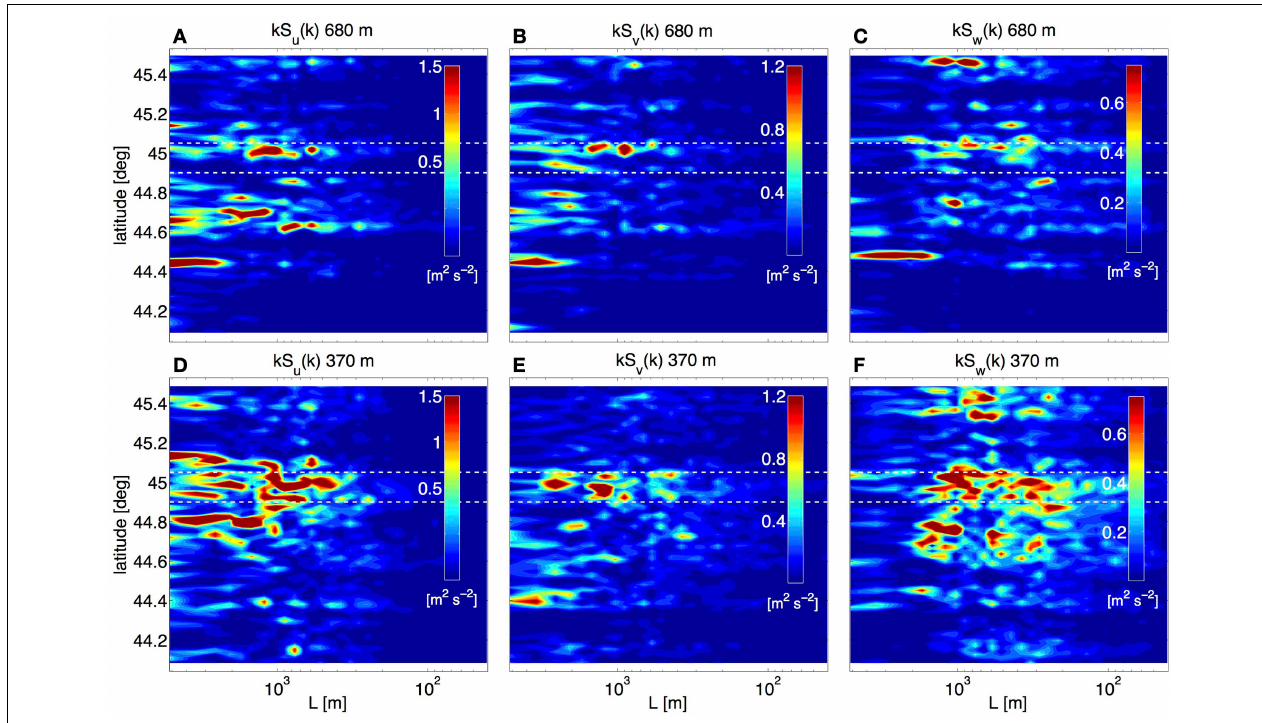
present in all plots around the latitude of 45 ◦ N. The spectra are calculated on overlapping subintervals of 512 data points (about 10km long) which slide by 103 data points (about 2km), thus obtaining 100 spectra over the 216-km long flight legs. The y-axis values correspond to the central latitudes of subintervals.